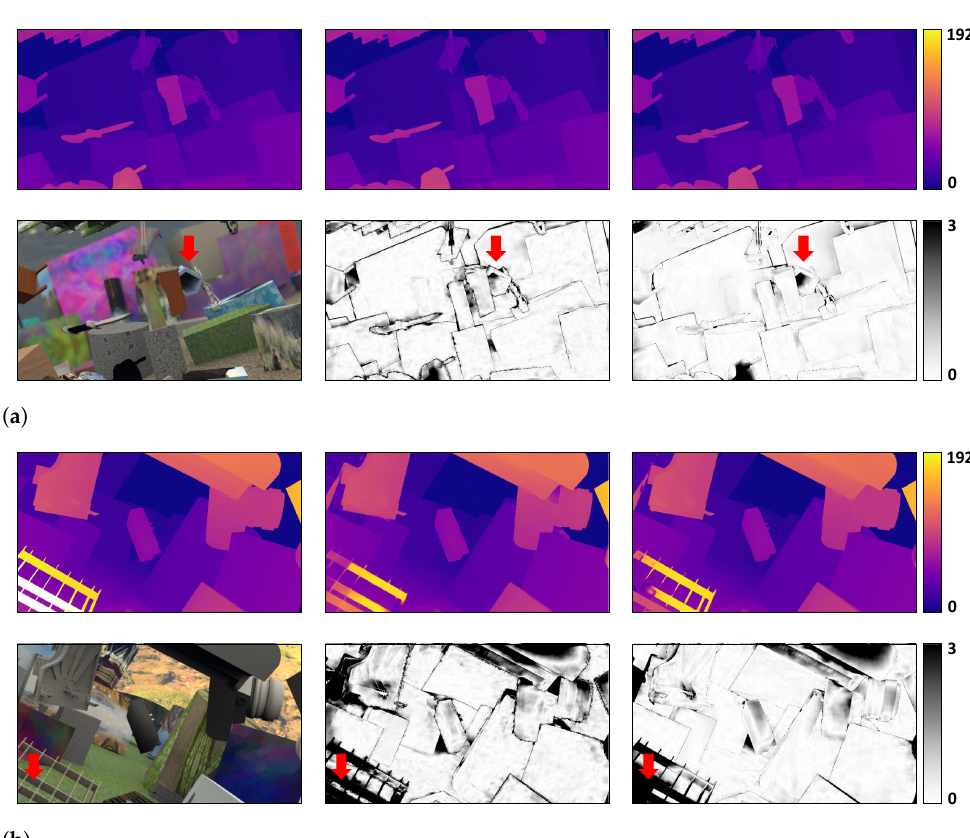
Figure 3. Visual comparison on Scene Flow data. Two test cases are displayed in subfigure ( a , b ). In each subfigure, the disparity maps from the ground truth, GA-Net-PyramidID+SPN and GA-Net are displayed from left to right in the first row. The second row provides the master epipolar image and the corresponding error map of each model. Regions where the proposed algorithm outperforms GA-Net are marked with red